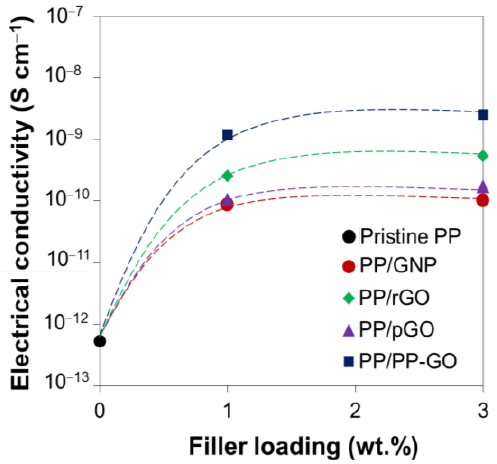
Figure 10. Electrical conductivity of PP nanocomposites at different filler loadings.